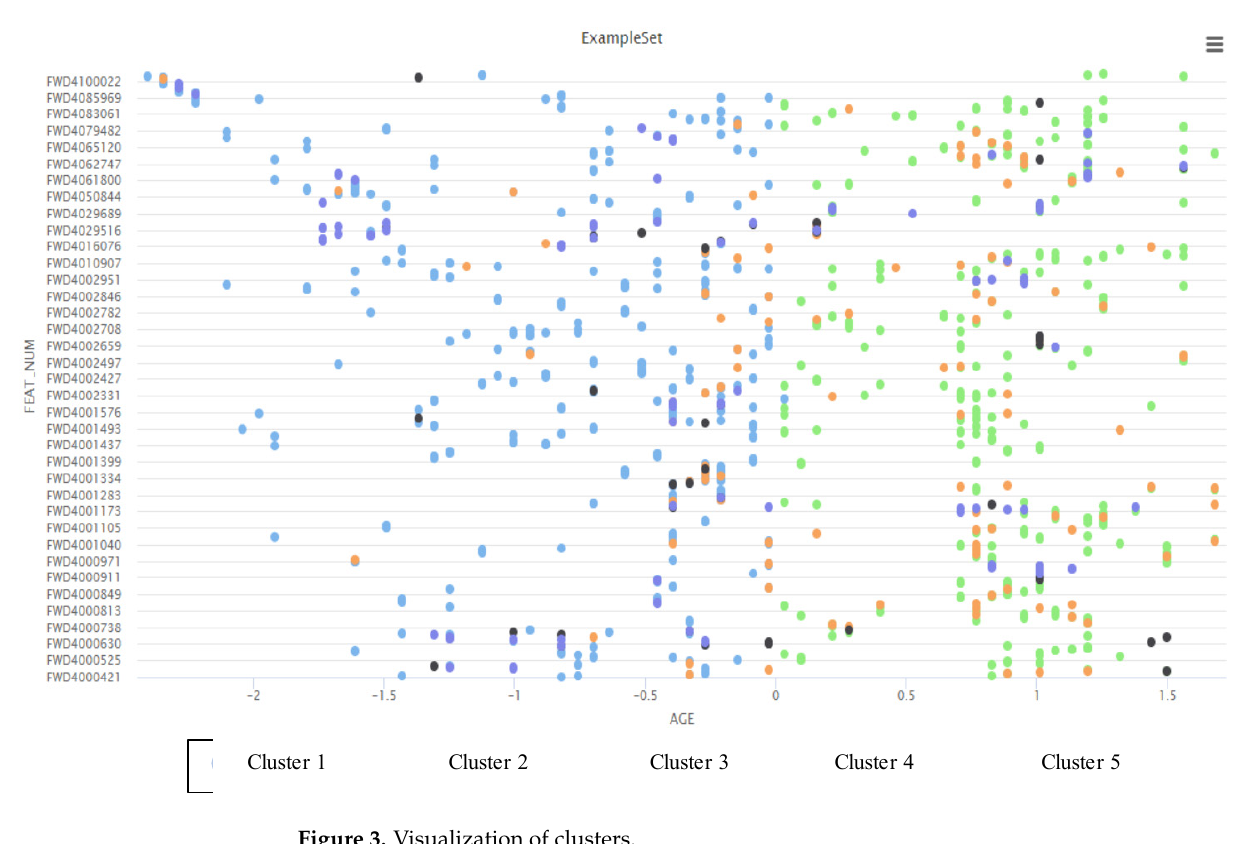
Figure 3. Visualization of clusters.